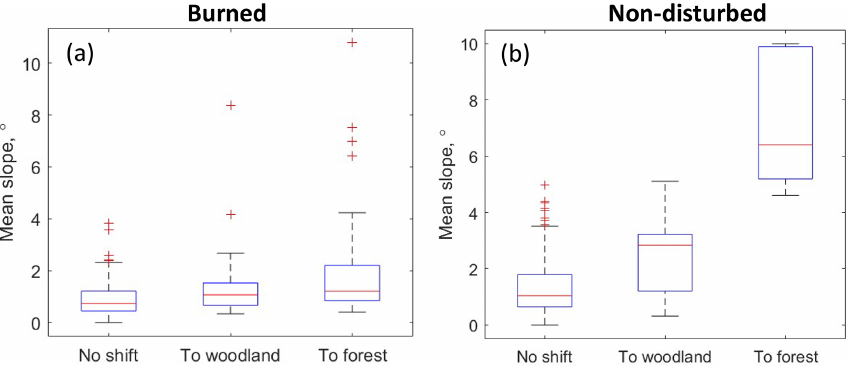
Figure 11. Median boxplots of the mean topographic slopes within the sample circles. Red line – median values, bottom and top edges of boxes – 25th and 75th percentiles, whiskers – 5th and 95th percentiles, and red crosses –